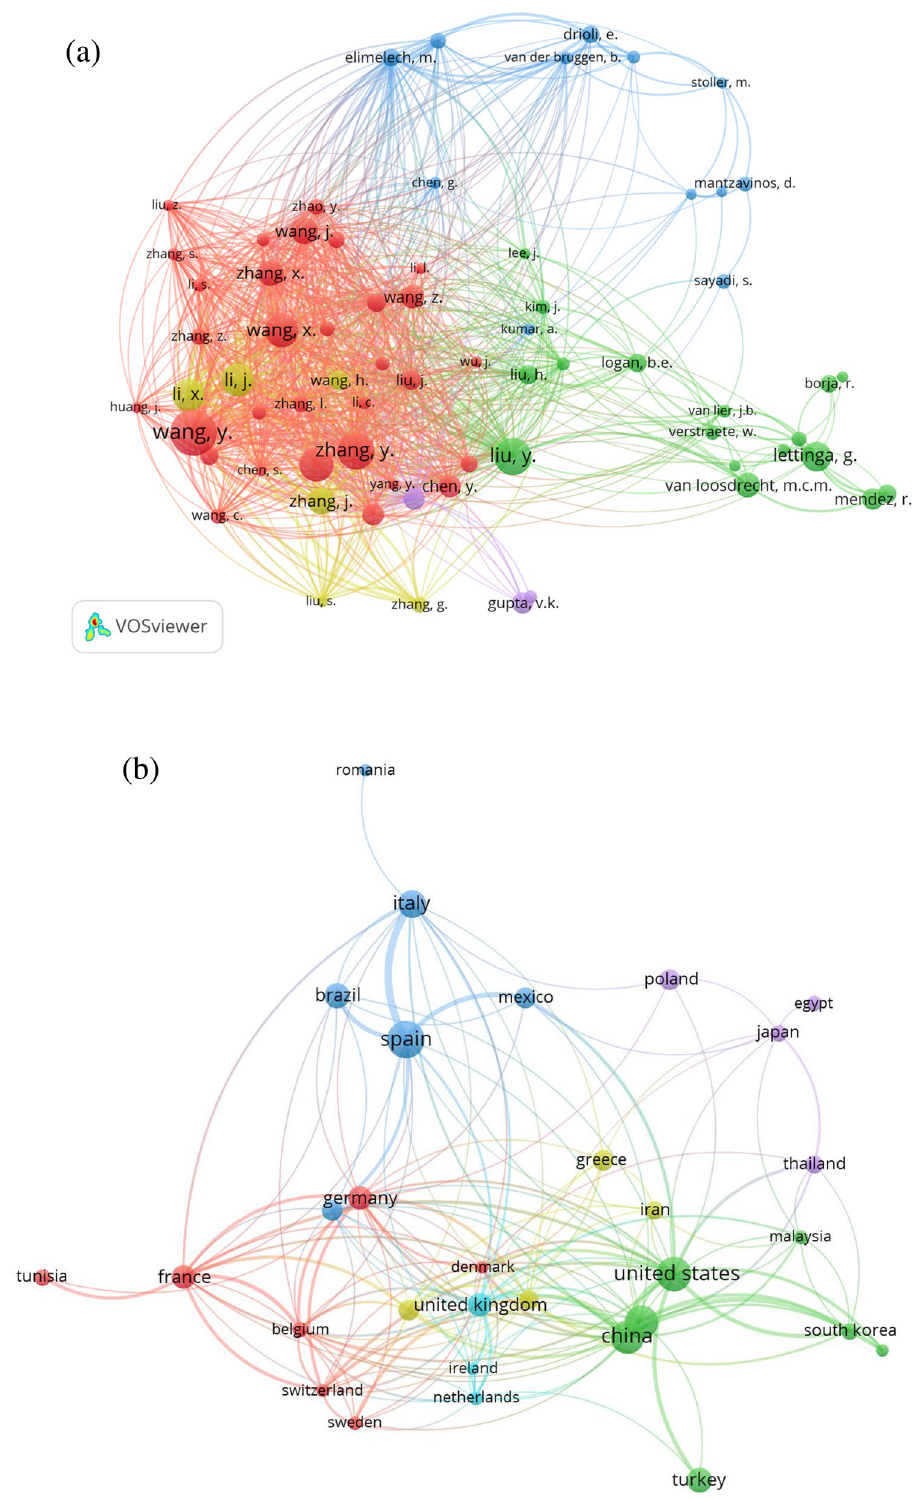
Fig. 6 Network visualization ( a ) co-citation researchers with minimum 50 citations ( b ) co-authorship countries with minimum 10